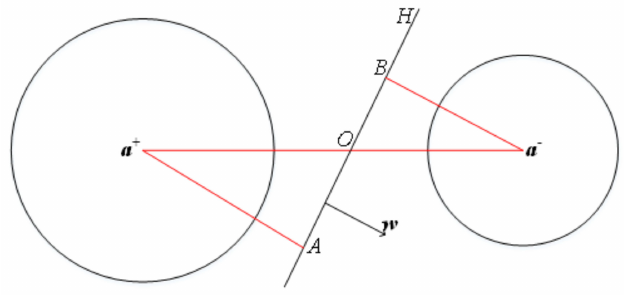
Figure 4. Maximize the sum of the distances.